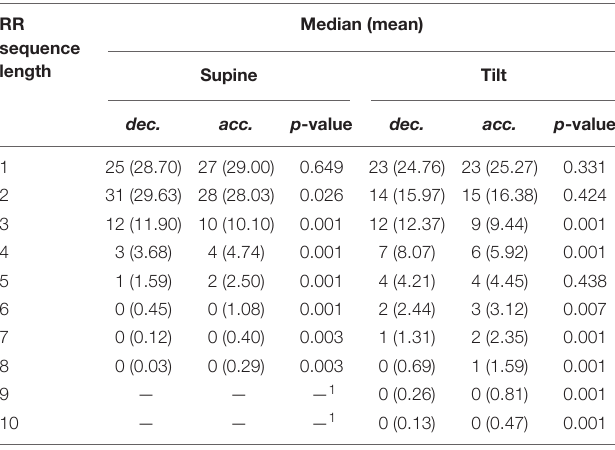
TABLE 7 | Comparison of average number of deceleration and acceleration series in supine and tilt. Monotonic series of no more than eight consecutive heartbeats has been compared in supine, and no more than 10 heartbeats in